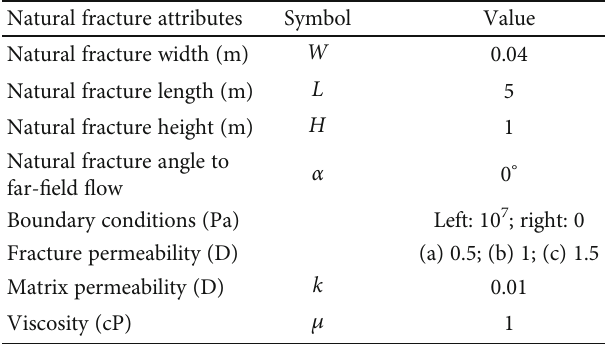
Table 3: Natural fracture attributes for the simpli fi ed synthetic model (EDFM and